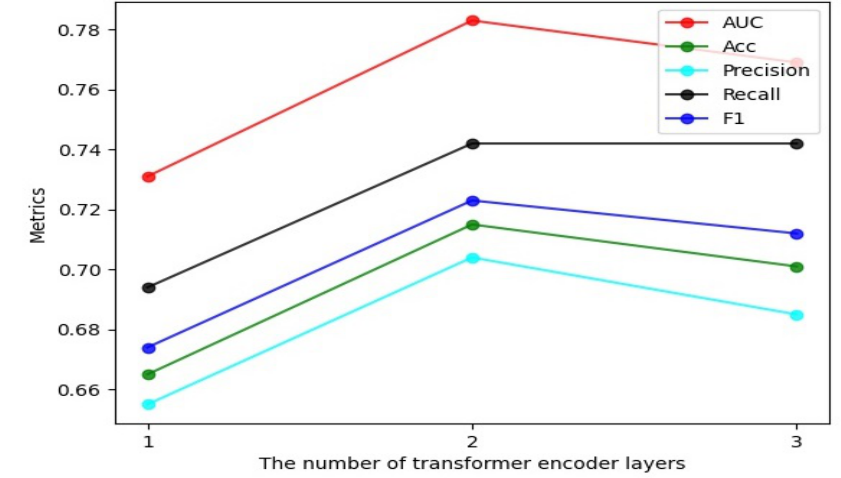
Figure 6. Effect of the number of transformer encoder layers on the experiment on Book- Crossing